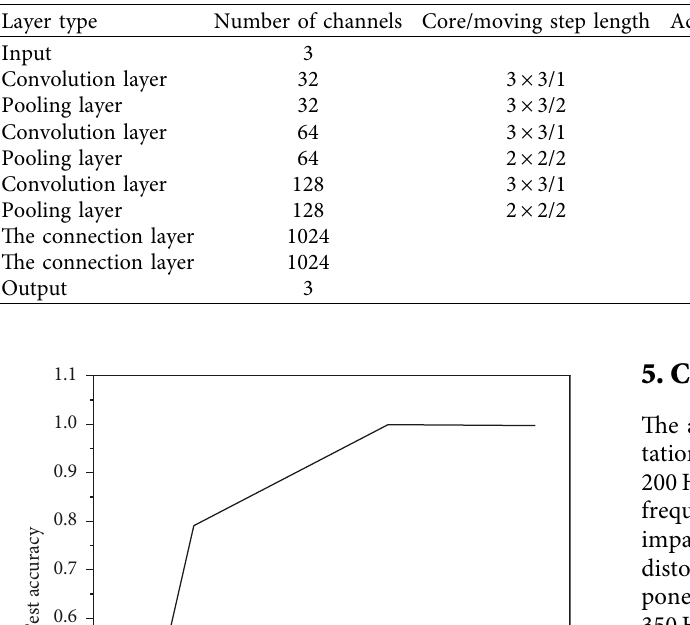
Table 2: CNN network structure used for transformer core voiceprint recognition.